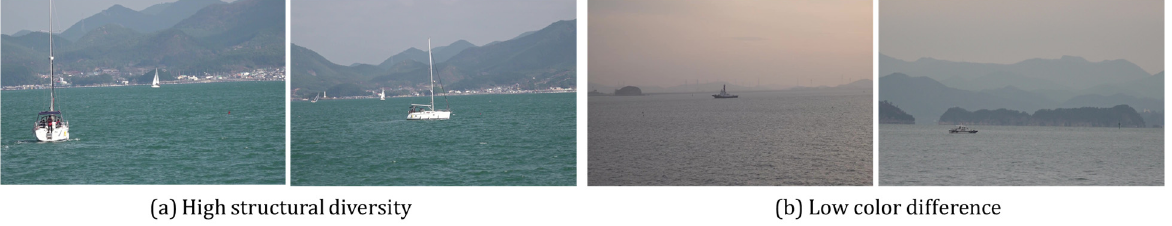
Figure 2. Examples of marine data wherein image-feature extraction is difficult; ( a ) example of high structural diversity, and ( b ) example of low color difference.